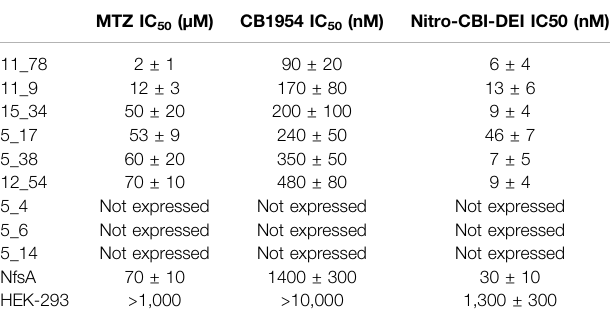
TABLE 2 | IC 50 values for stably-transfected HEK-293 cell lines expressing one of the nine selected NfsA variants, or wild type NfsA, following challenge with metronidazole (MTZ), CB1954 or